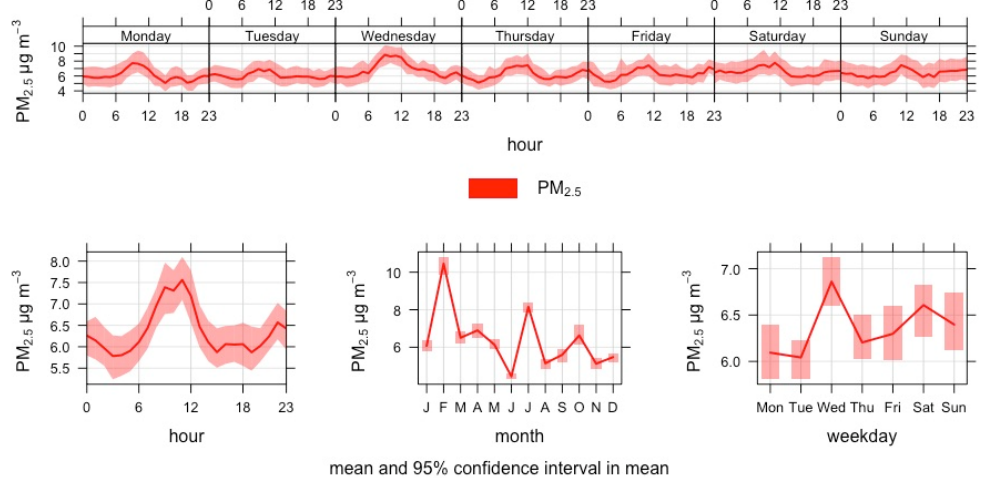
Figure 9. Time variation plot of PM 2 . 5 concentration at Helsinki South Harbour in 2018. The multivariable linear regression shows a statistically signi fi cant association be- tween arrivals, departures, movement and vessels at berth and the natural logarithm of hourly PM 2 . 5 concentrations when adjusted for wind direction, wind speed, relative hu- midity and time of day (Table 7) during the whole year. However, departures were not statistically signi fi cant in the weekend-only models. Air temperature was removed from the models as it was not statistically signi fi cant and did not improve the fi t between ob- served and fi tt ed values. Time of day was removed from the weekend models for the same reason. The largest e ff ect was found with vessel arrivals to the Olympia quay, which cor- respond to 22.3% of the hourly mean PM 2 . 5 (95% con fi dence interval 12.7–32.7%). The models for the whole year explain 14% and the models for the weekend only explain 25% of the variation in PM 2 . 5 hourly mean concentrations. Based on the analyses, the associa- tion between vessel movement and hourly mean PM 2 . 5 concentrations is weak, but with a positive signal for the vessels berthing at the Olympia quay.